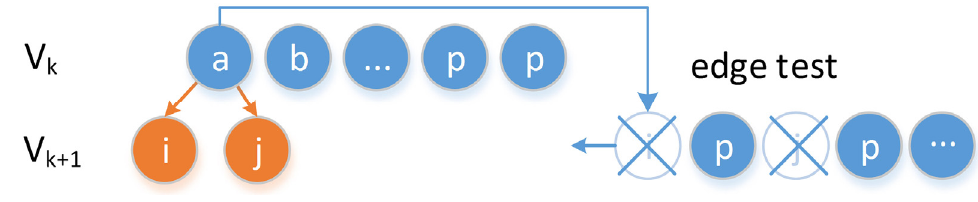
Figure 9. Dynamic construction of the spanning tree.